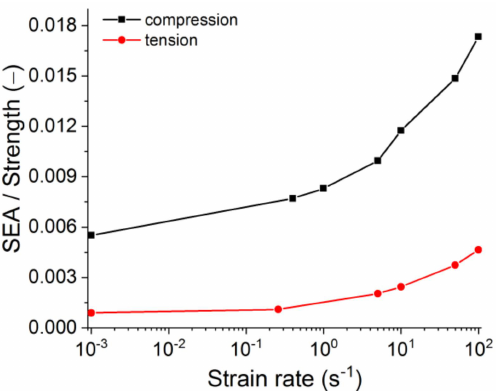
Figure 14. The dependence of the ratio of specific energy absorption to strength on the strain rate.